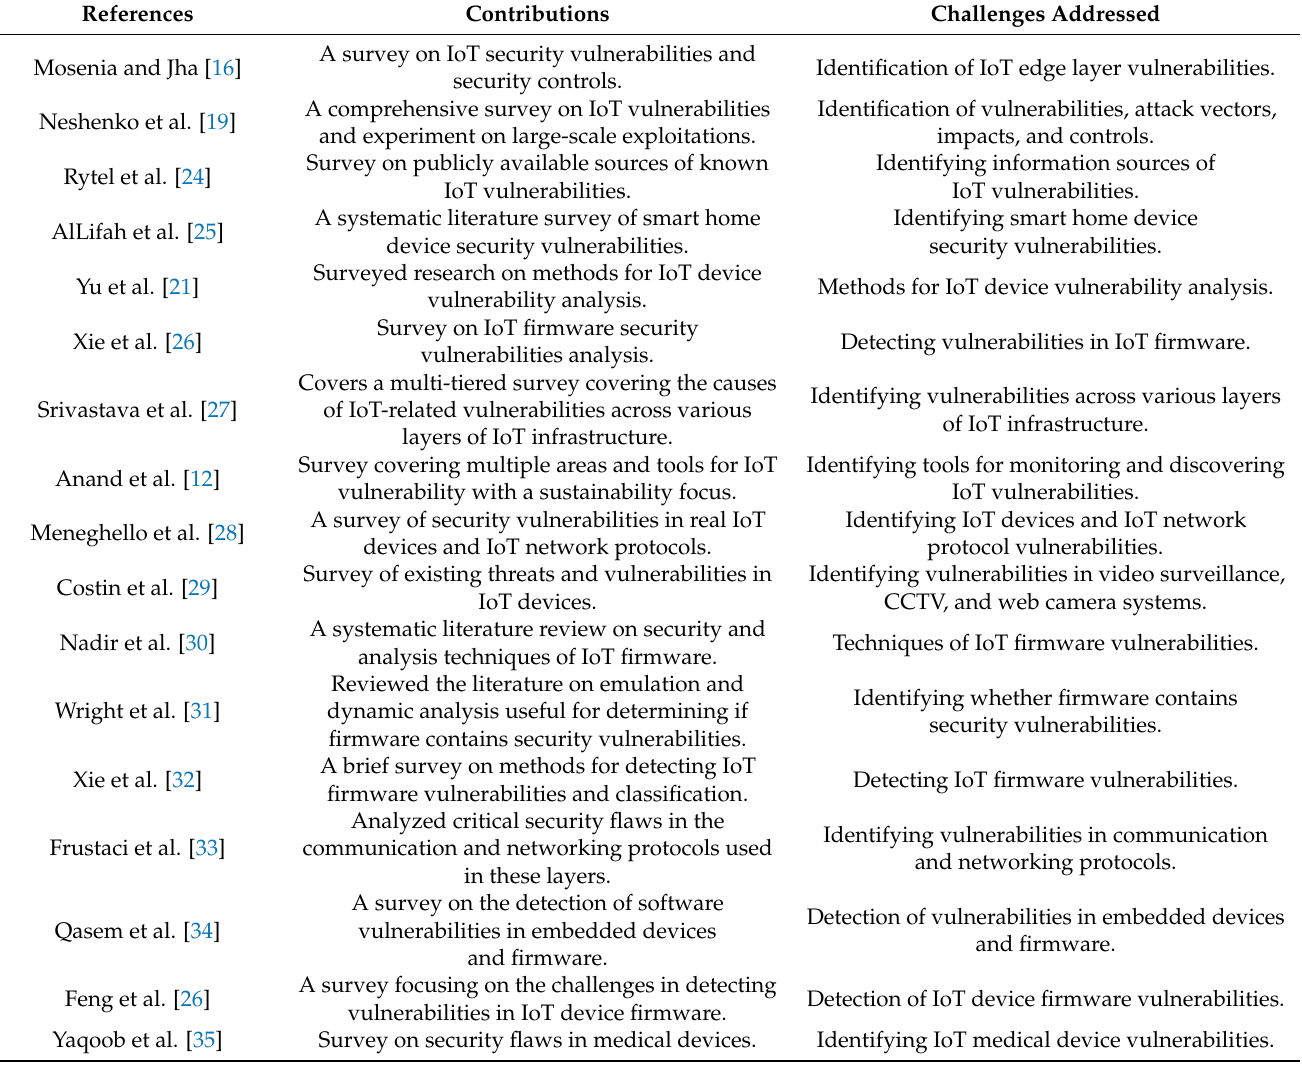
Table 1. Comparative analysis of recent work on IoT security